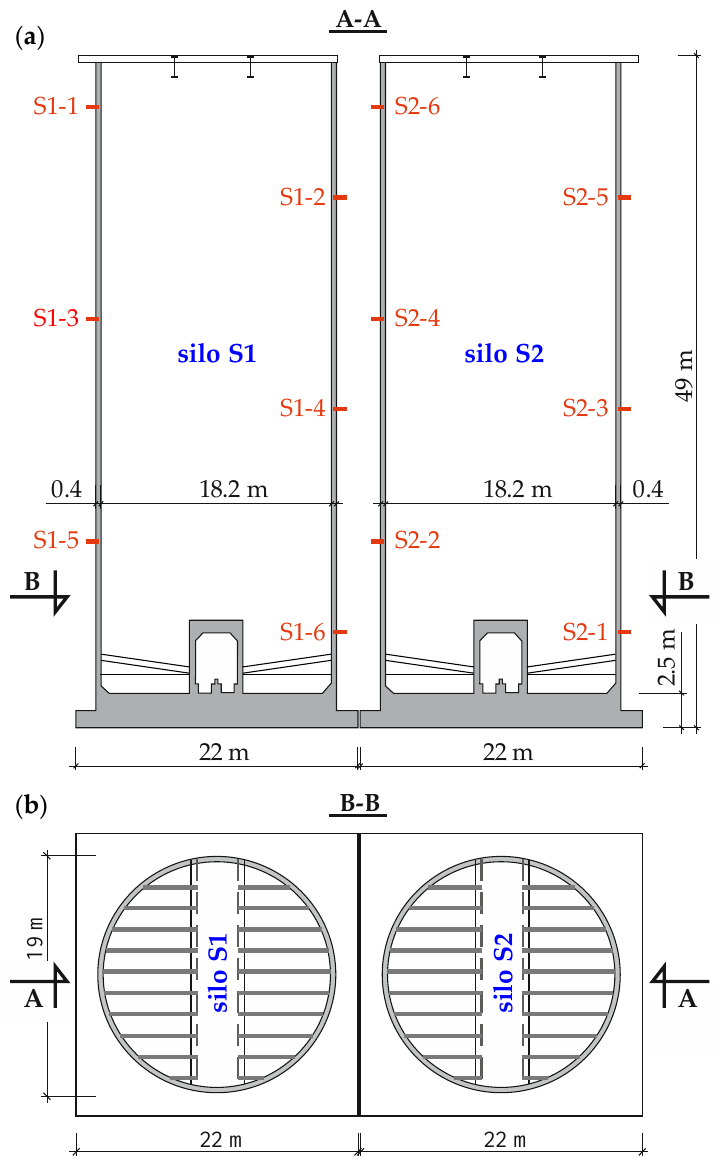
Figure 8. The tested structure of cylindrical reinforced concrete silos for cement: ( a ) cross-section A-A; and ( b ) longitudinal section B-B; symbols S1-1 – S1-6 and S2-1 – S2-6 show places of drilling cylin-